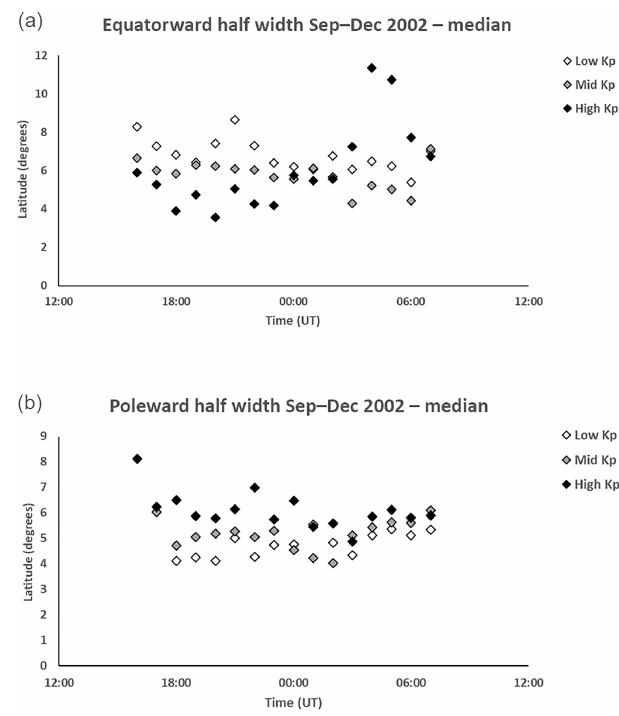
Figure 7. (a) Median equatorward half-width of the trough from 16:00 to 07:00UT for low Kp (0 to 2 + ) , medium Kp (3 − to 4) and high Kp ( ≥ 4 + ) . The representative interquartile range is approxi- mately 3.0 ◦ latitude. The equatorward half-width prior to 04:00UT is generally largest for the low Kp level and smallest for the the high Kp level. (b) Median poleward half-width of the trough from 16:00 to 07:00UT for low Kp (0 to 2 + ) , medium Kp (3 − to 4) and high Kp ( ≥ 4 + ) . The representative interquartile range is approximately 2.5 ◦ latitude. In contrast to Fig. 7a, the poleward widths tend to be largest for the high Kp levels and smallest for the low Kp